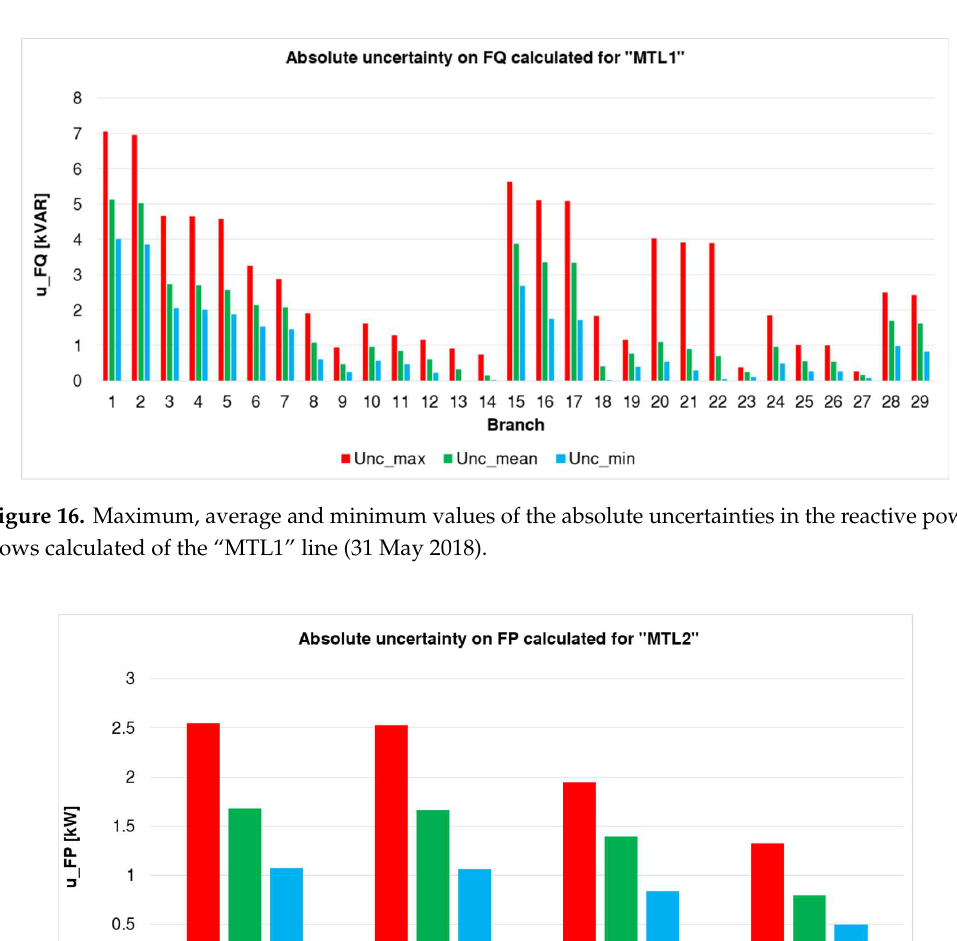
Figure 15. Maximum, average and minimum values of the absolute uncertainties in the calculated active power flows of the “MTL1” line (31 May 2018).